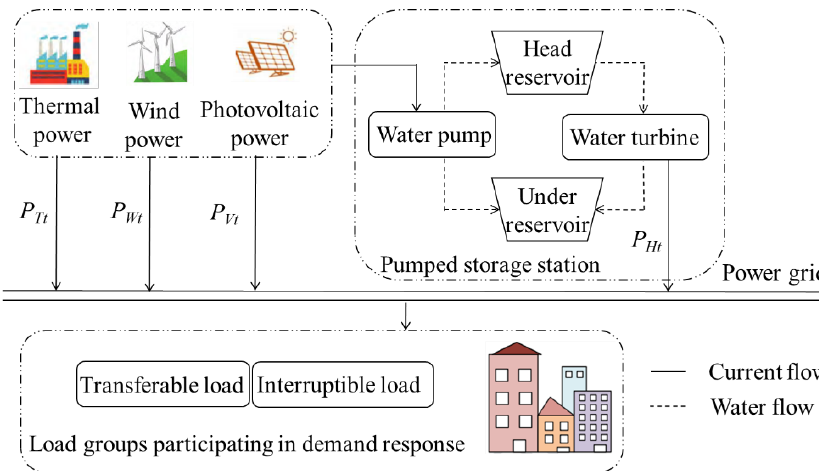
Figure 1. Multi-source complementary system architecture.